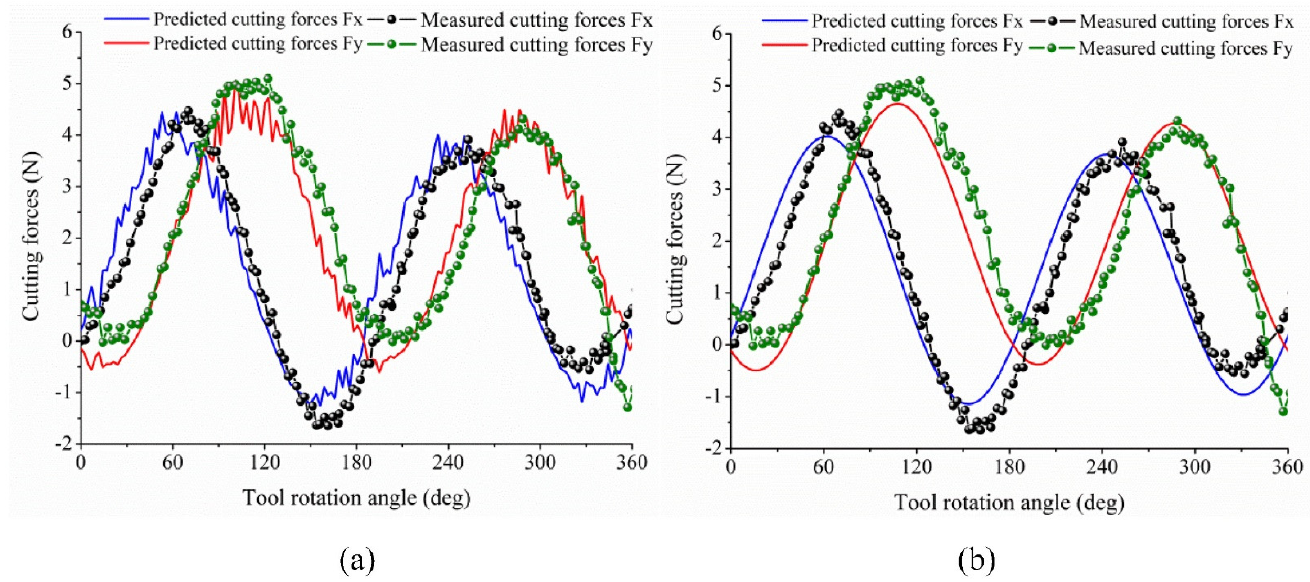
Figure 4. Comparison results of measured and predicted cutting forces ( a ) with considering the effect of stochastic tool wear ( b ) without considering the effect of stochastic tool wear [80]. energy consumption patterns in turning [81]. Wirtz et al. have studied the simulation-